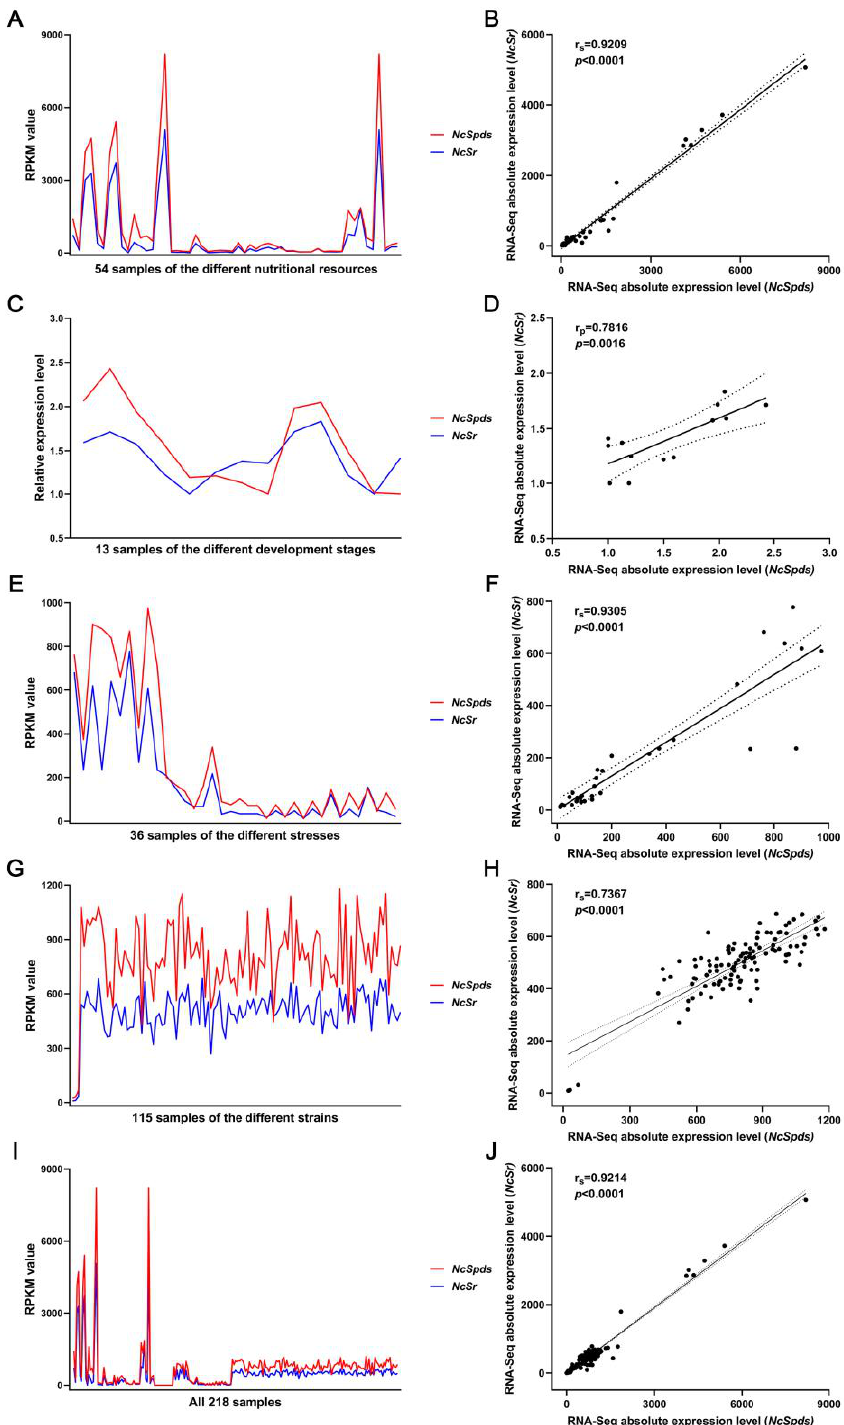
Figure 5. Correlation analyses of expression levels of NcSpds and NcSr in N. crassa . ( A , B ) Correlation analyses of expression levels of NcSpds and NcSr in the different nutritional resources, including avicel, sucrose, no carbon, xylan, barleystraw, cornstraw, rice straw, soybean straw, wheatstraw, pectin, orange peel powder (OPP), L-arabinose, D-glucose, and D-xylose (RNA-Seq data: GSE35227, GSE44100, GSE44673, GSE52316, GSE60986, GSE68517, GSE42692 and GSE51091). ( C , D ) Correlation analyses of expression levels of NcSpds and NcSr in the different development stages, including perithecium wall (PW), centrum parenchyma (CP), asci (AS), paraphyses (PP), and ostiole (OS) (RNA-Seq data GSE41484). ( E , F ) Correlation analyses of expression levels of NcSpds and NcSr